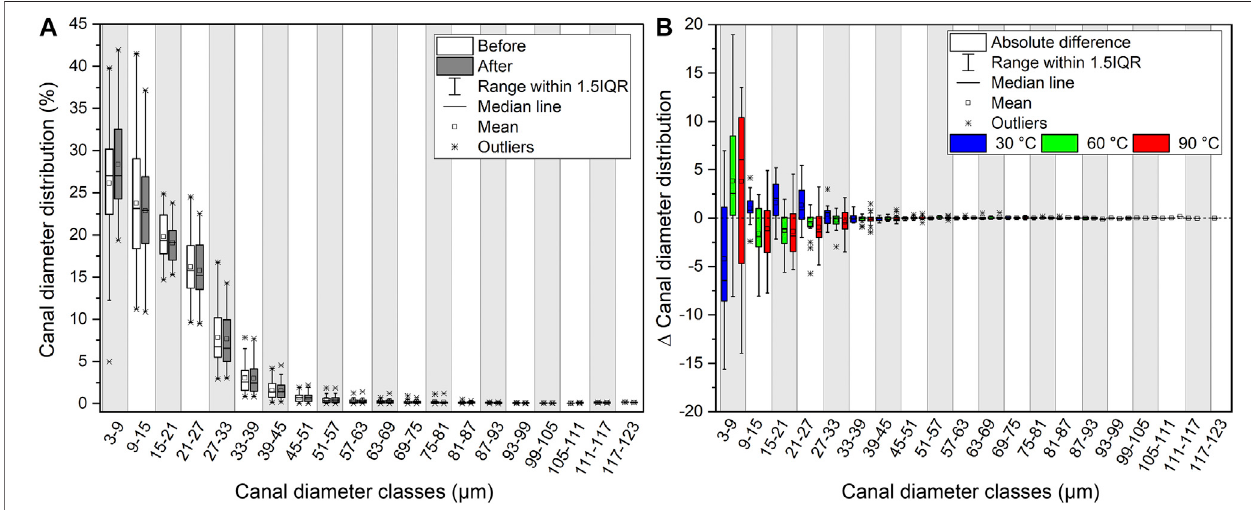
FIGURE5| Changesincanaldiameterdistribution. (A) Canaldiameterdistribution(%)foreverysamplescannedbeforeandaftertheexperiments( n (cid:1) 45)shownin classes of 6 µm range each. (B) Difference of the percentage share of each canal diameter class before and after the experiments. The differences in canal diameter of each class are displayed for the three temperature series 30 ° C ( n (cid:1) 9), 60 ° C ( n (cid:1) 18), and 90 ° C ( n (cid:1) 18).